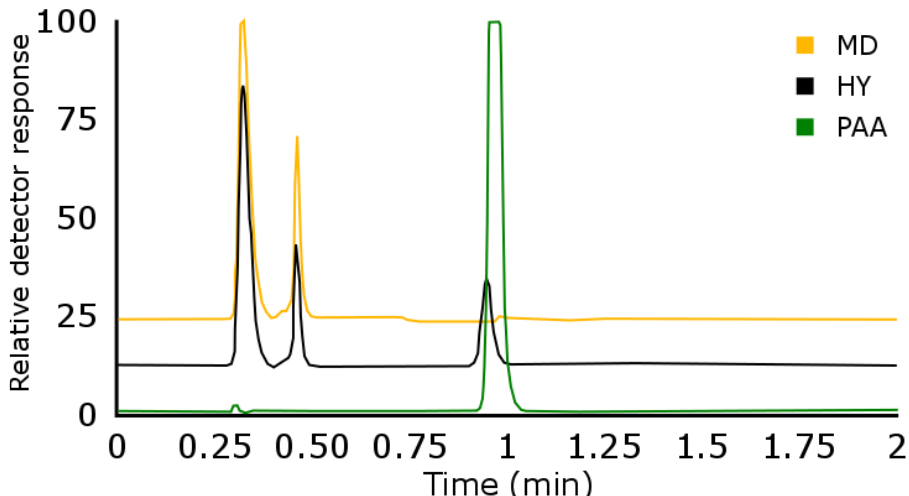
Figure 5. Fast RPLC for 2 D separation. Chromatograms of PAA, HY, and MD samples (5 µL of 1 mg/mL injection), obtained on a Titan C18 column (30 × 2.1 mm i.d., 1.9 μm particles) . Mobile phase A: 100% H 2 O (0.1% FA); mobile phase B: 100% ACN (0.1% FA); flow rate: 0.4 mL/min; gradient: 4–30% B, (0.5 to